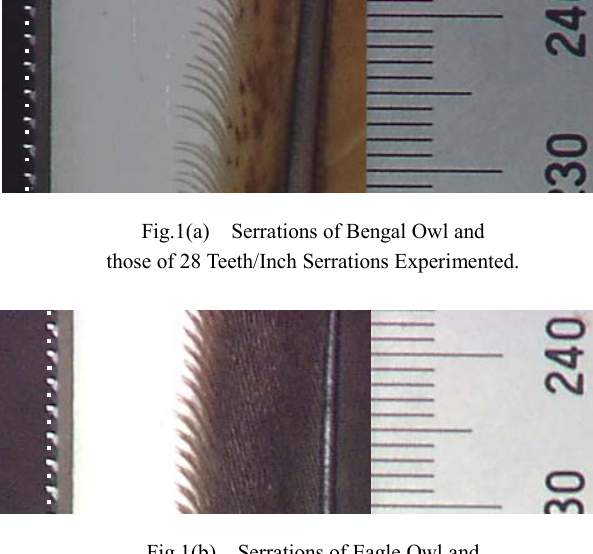
Fig.1(b) Serrations of Eagle Owl and those of 28 Teeth/Inch Serrations Experimented. Figs. 1 Serrations of Owls and those of a Jigsaw Blade